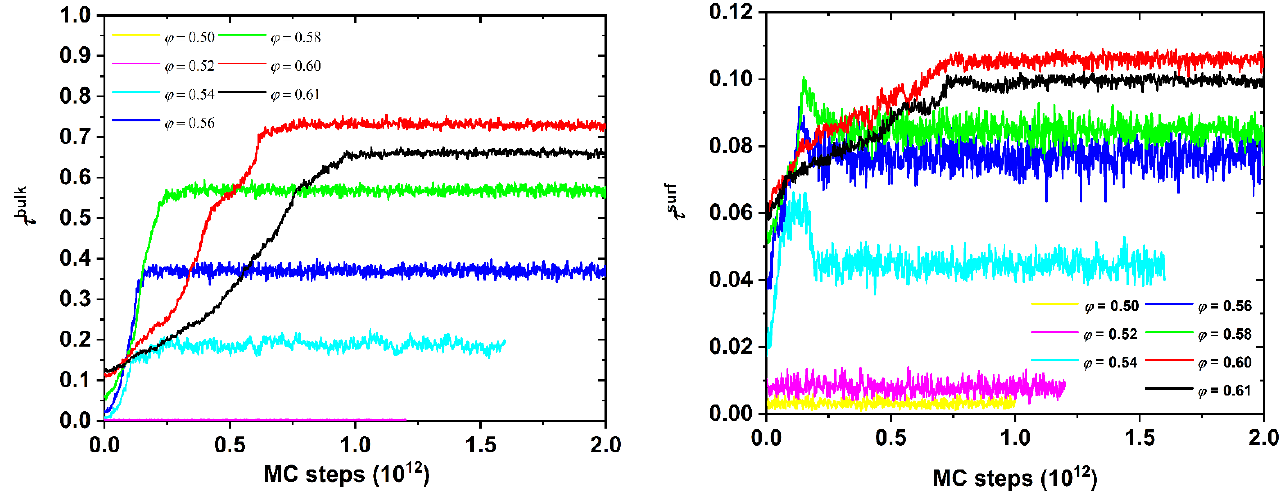
Figure 3. ( Left panel ) Bulk crystallinity, τ bulk , and ( right panel ) surface crystallinity, τ surf , as a function of the MC steps for the N = 100 system at various packing densities, ϕ .